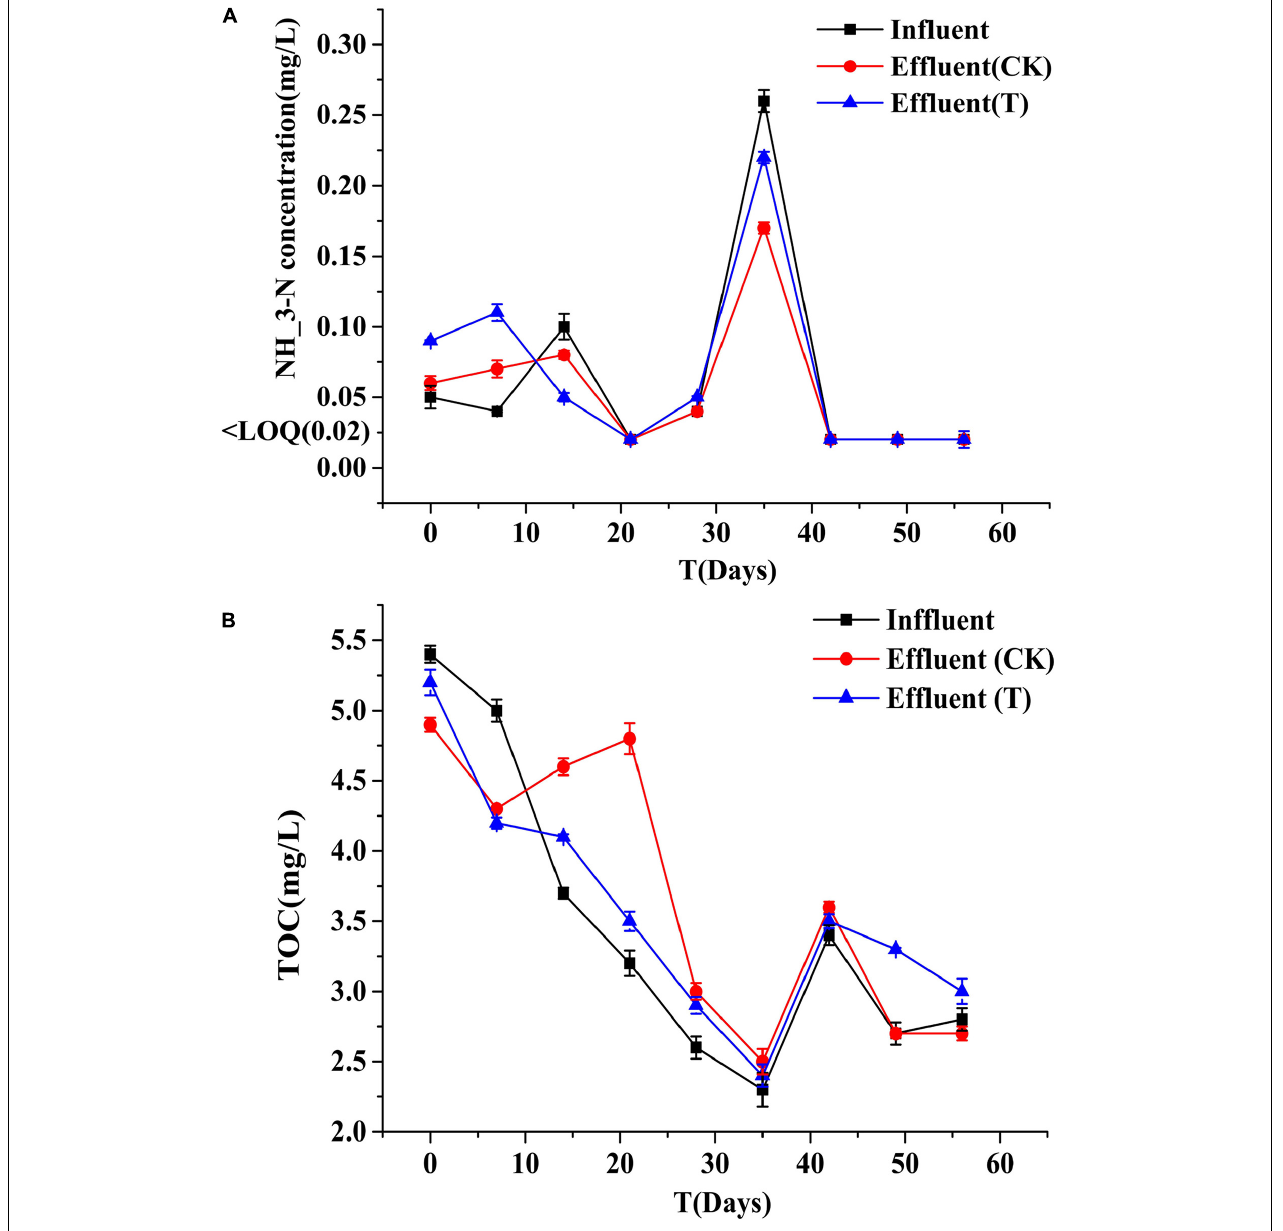
FIGURE 6 | NH 3 -N (A) and TOC (B) concentrations of the influent and effluents. Error bars indicate standard deviation ( n =